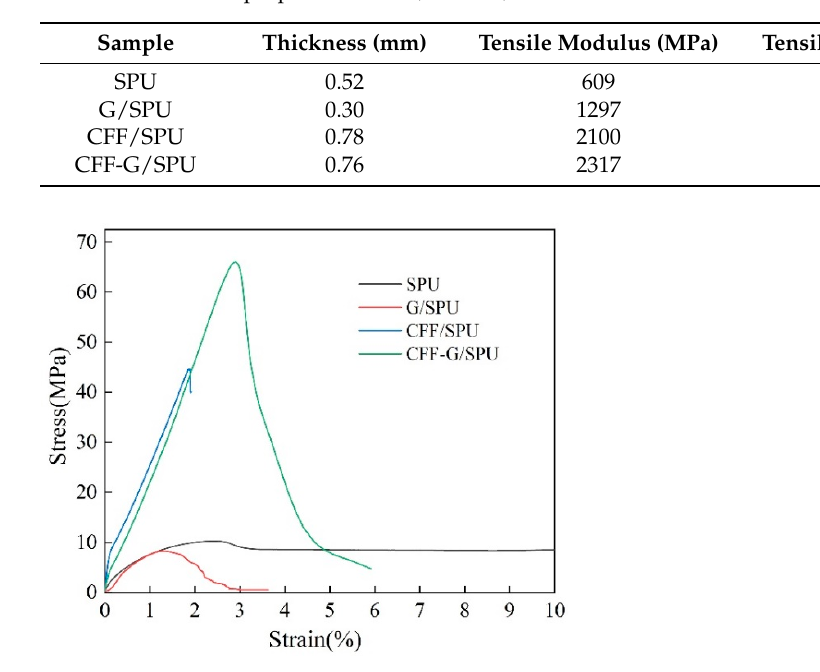
Figure 5. Stress–strain curses of SPU, G/SPU, CFF/SPU and CFF-G/SPU.